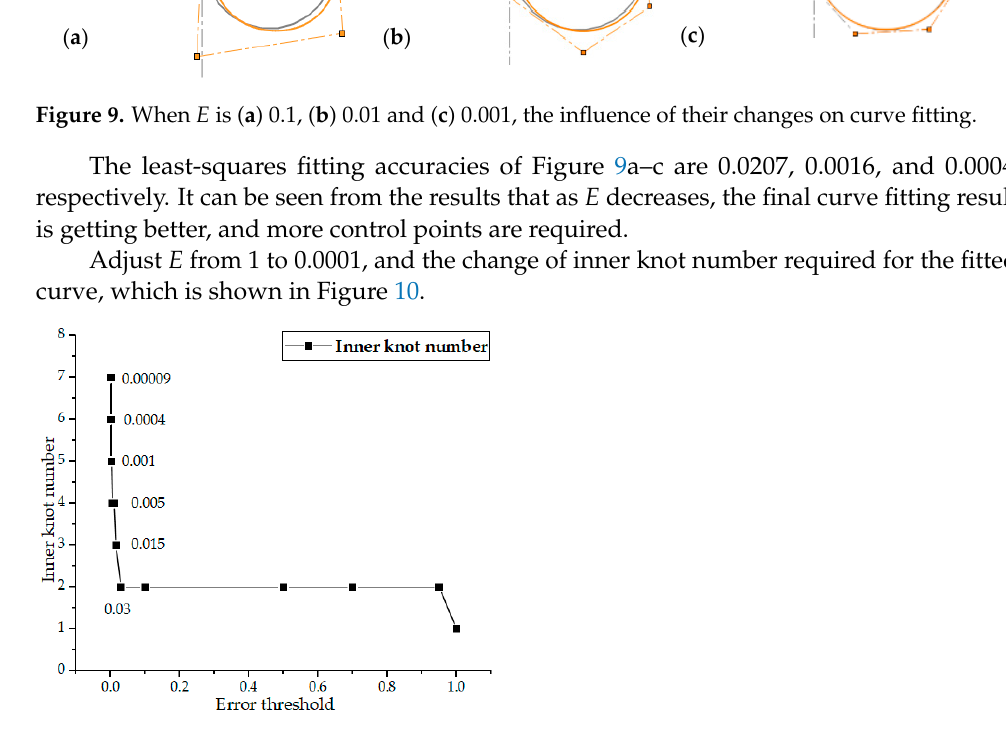
Figure 9. When E is ( a ) 0.1, ( b ) 0.01 and ( c ) 0.001, the influence of their changes on curve fitting.